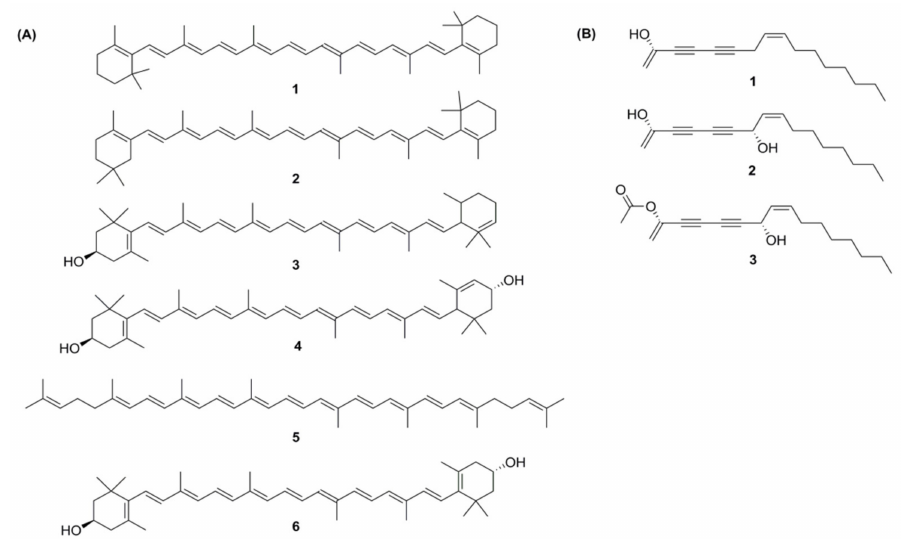
Figure 4. ( A ) Structures of carotenoids: (1) α -carotene; (2) β -carotene; (3) β -cryptoxanthin; (4) lutein; (5) lycopene; (6) zeaxanthin; ( B ) Structures of the polyacetylenes: (1) falcarinol; (2) falcarindiol; (3)